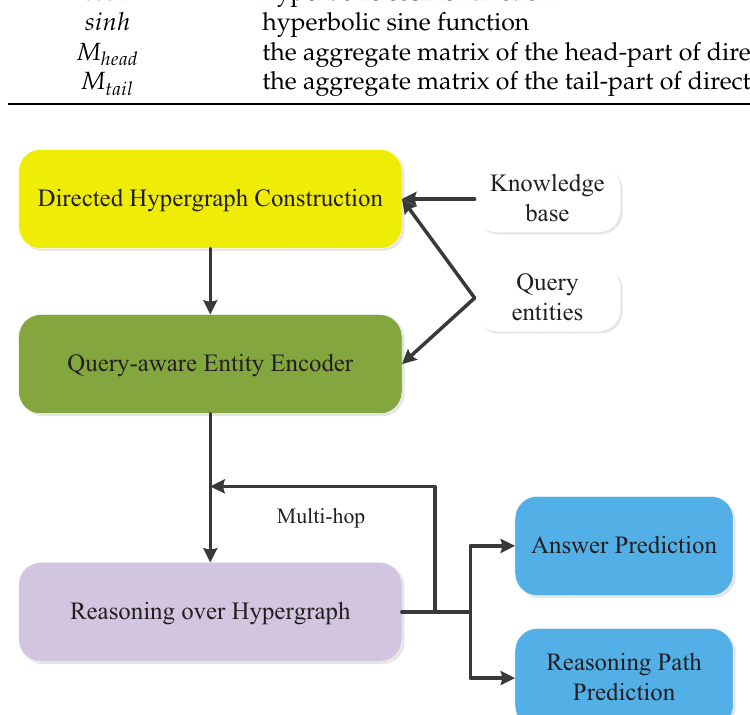
Figure 2. An overview of how the model